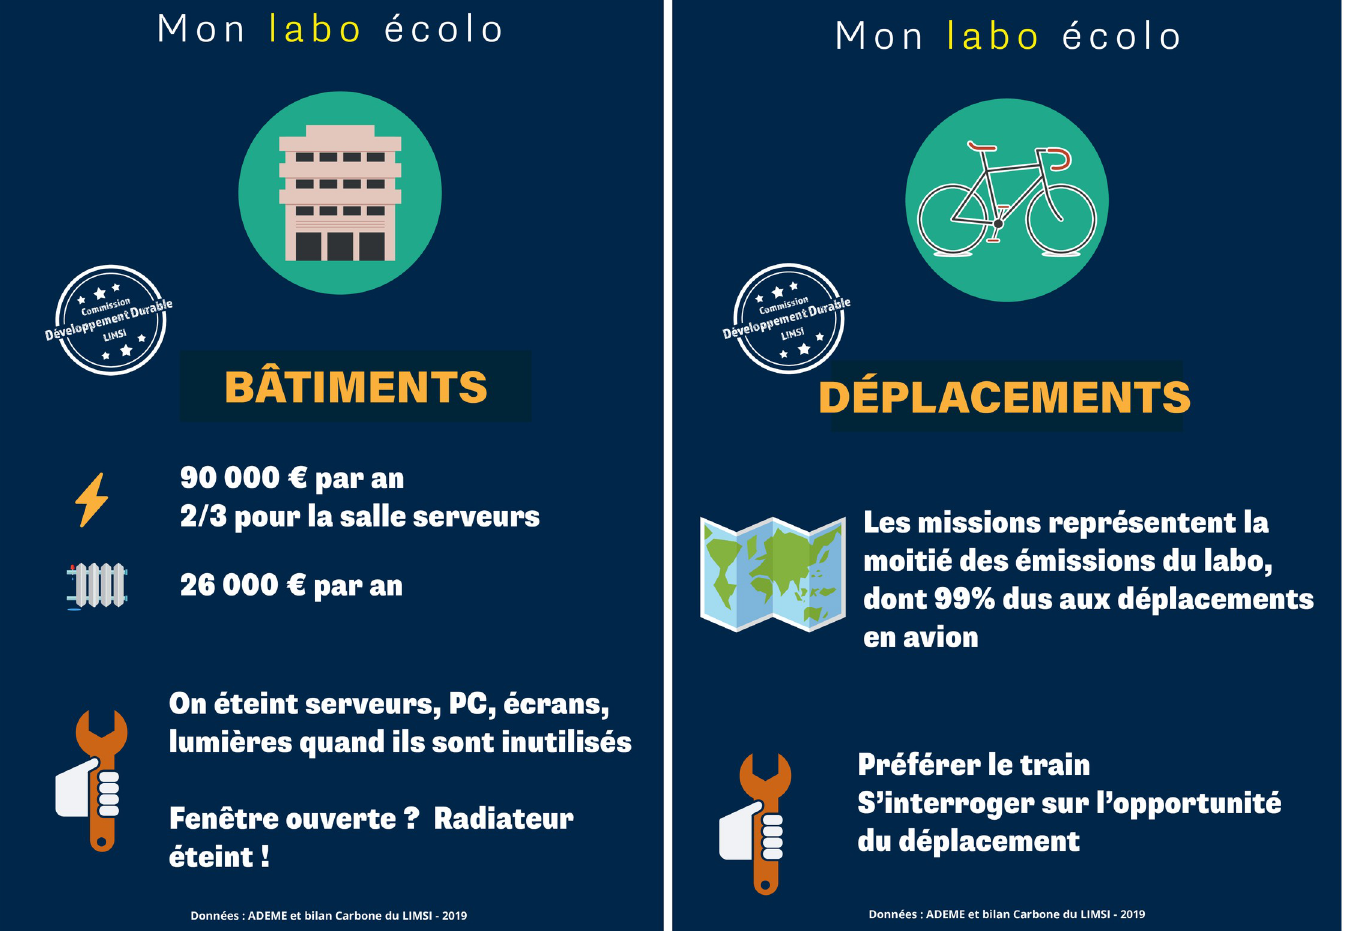
Fig 2. Sample handout providing information on building related power usage in Fig 2A and on travel in Fig 2B. (A) Translation of hand-out content into English: “My Green Lab—BUILDINGS—(electricity) 90,000 € pa, 2/3 for server room (heat) 26,000 € pa (action) Switch off servers, computers, screens, lights when not in use. Open window? Radiator off!” (B) Translation of hand-out content into English: “My Green Lab—TRAVEL—(map) travel is responsible for half of the lab’s carbon footprint, with plane travel accounting for 99% of the travel footprint (action) prefer train over plane; question the necessity of travel.” Text and design by Bénédicte Daly